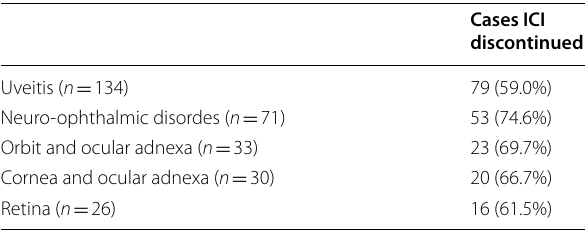
Table 7 ICI discontinuation